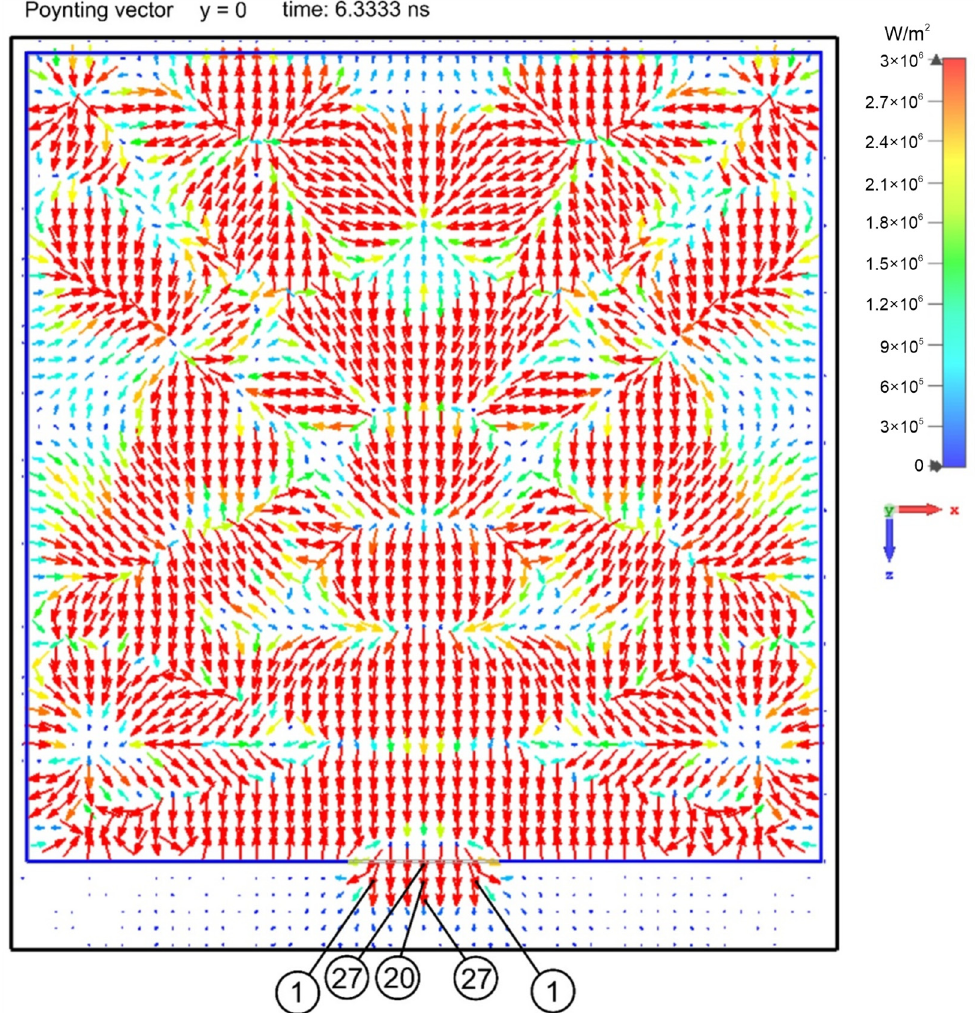
Figure 9. Illustration of the EM energy leakage through the aperture. Vector maps showing distri- bution of the Poynting vectors in the enclosure in the interference phase at time t = 6.333 ns. The Poynting vectors exiting the aperture represent the EM field power density leaving the enclosure. The amplitudes of the Poynting vector in 10 6 W/m 2 are given in circles.